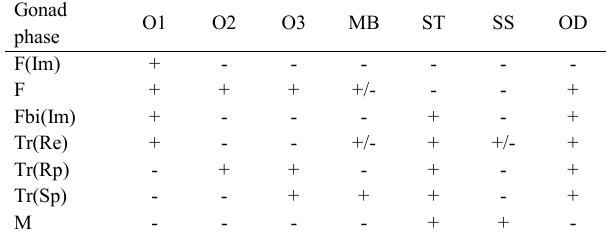
Table 3. Gonads of Alphestes afer in bisexual phases according to histological criteria. F(Im), immature female; F, ovarian phase of resting, ripening, ripe and spent female; Fbi(Im), immature bisexual phase of female; Tr(Re), transitional phase of resting female; Tr(Rp), transitional phase of ripe female; Tr(Sp), transitional phase of spent female; M, testicular phase of ripening, ripe, spent and resting male; O1,